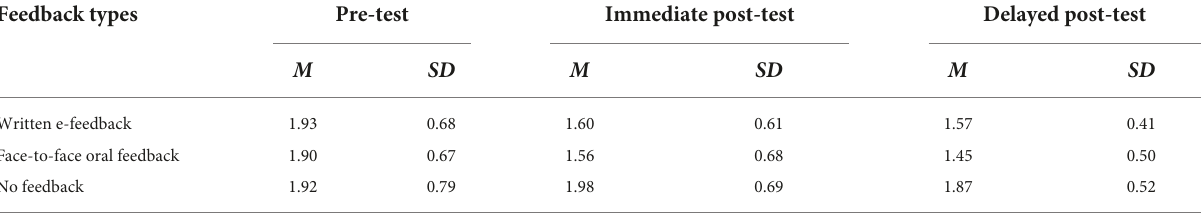
TABLE 4 Descriptive statistics of conjunction errors at pre and